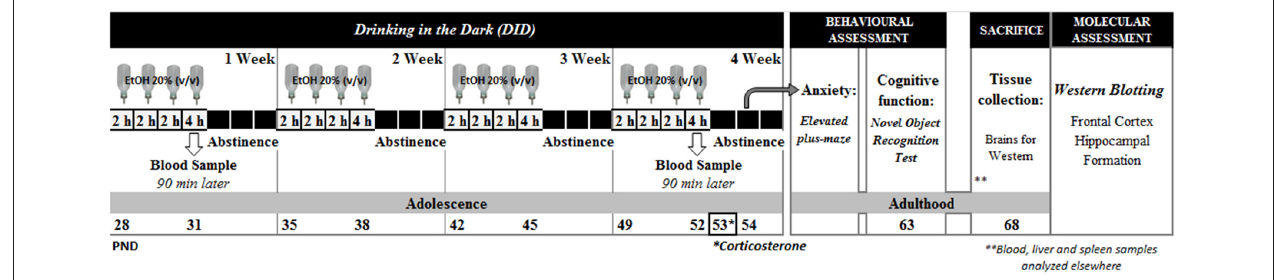
FIGURE 1 | Experimental design.